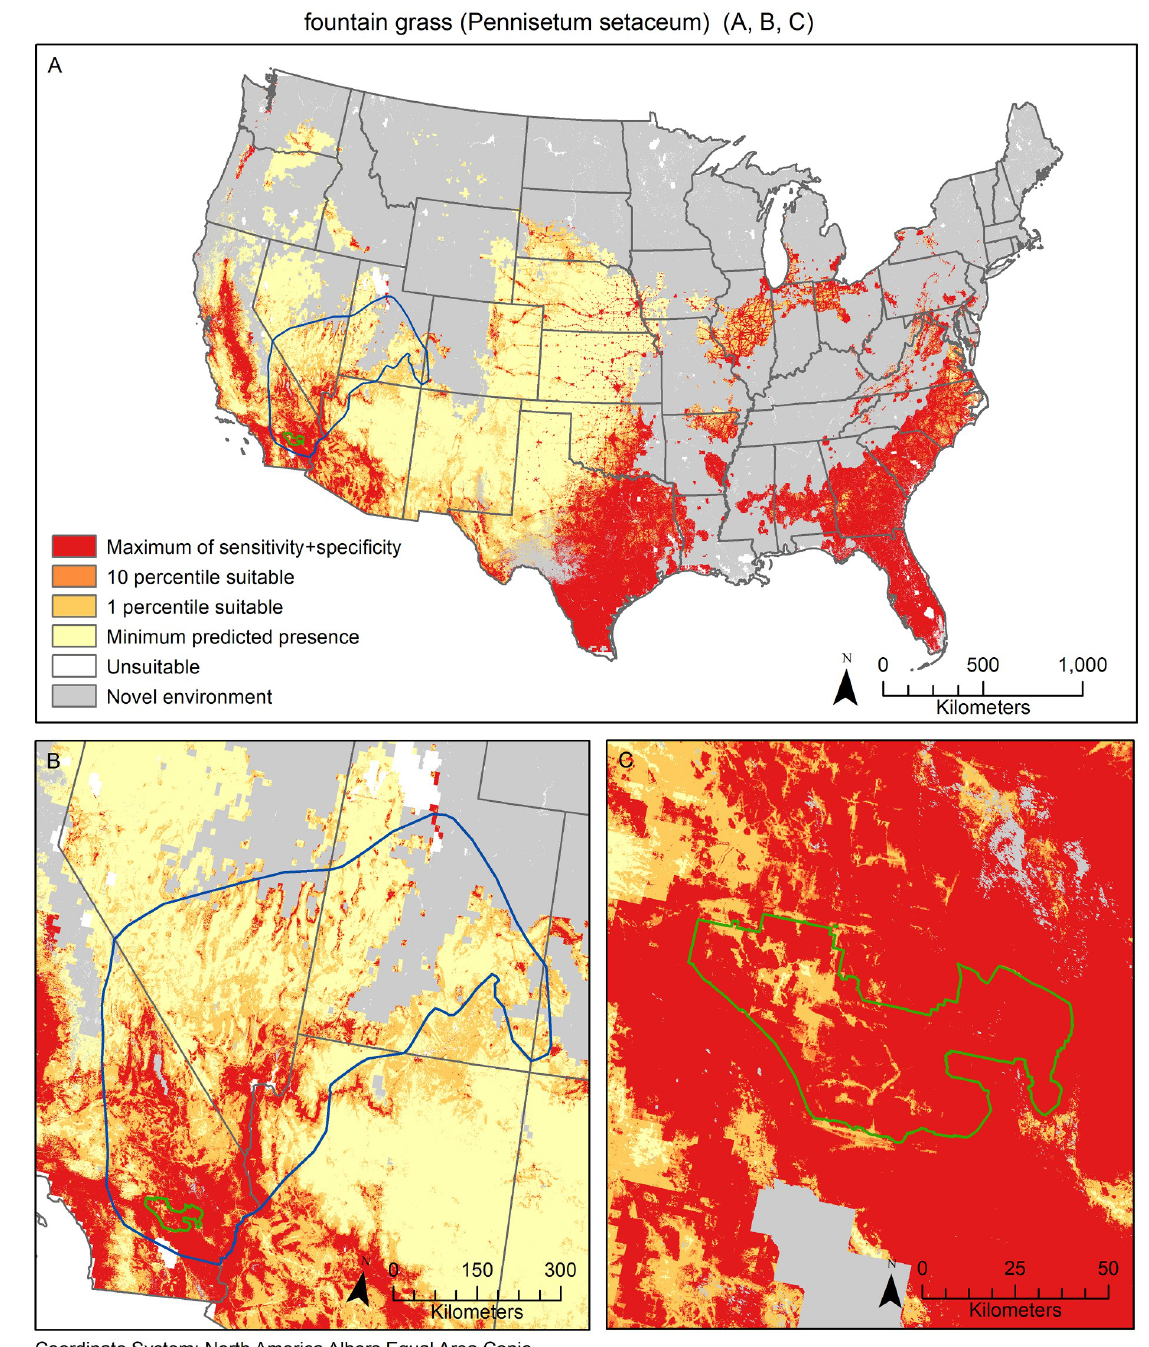
Fig 4. Fountain grass ( Pennisetum setaceum ) models of four different thresholds including minimum predicted presence (MPP), one percentile, ten percentile and maximum of sensitivity plus specificity (MSS). Model predictions are shown at three scales; A) national, B) regional (Lake Mead Exotic Plant Management Team region in blue) and C) local (Joshua Tree National Park in green).